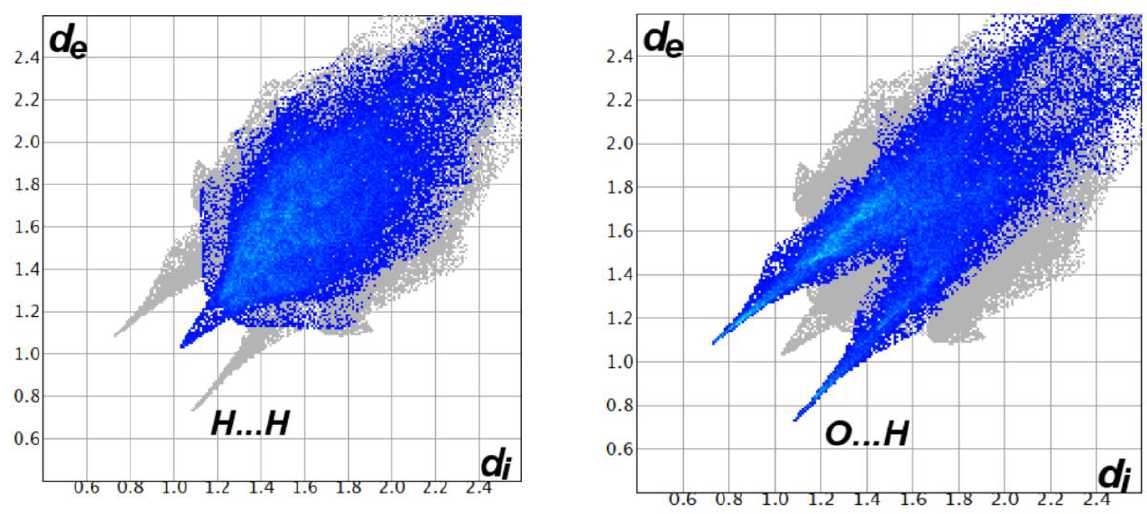
Figure 9. Decomposed fingerprint plots in complex 1 .